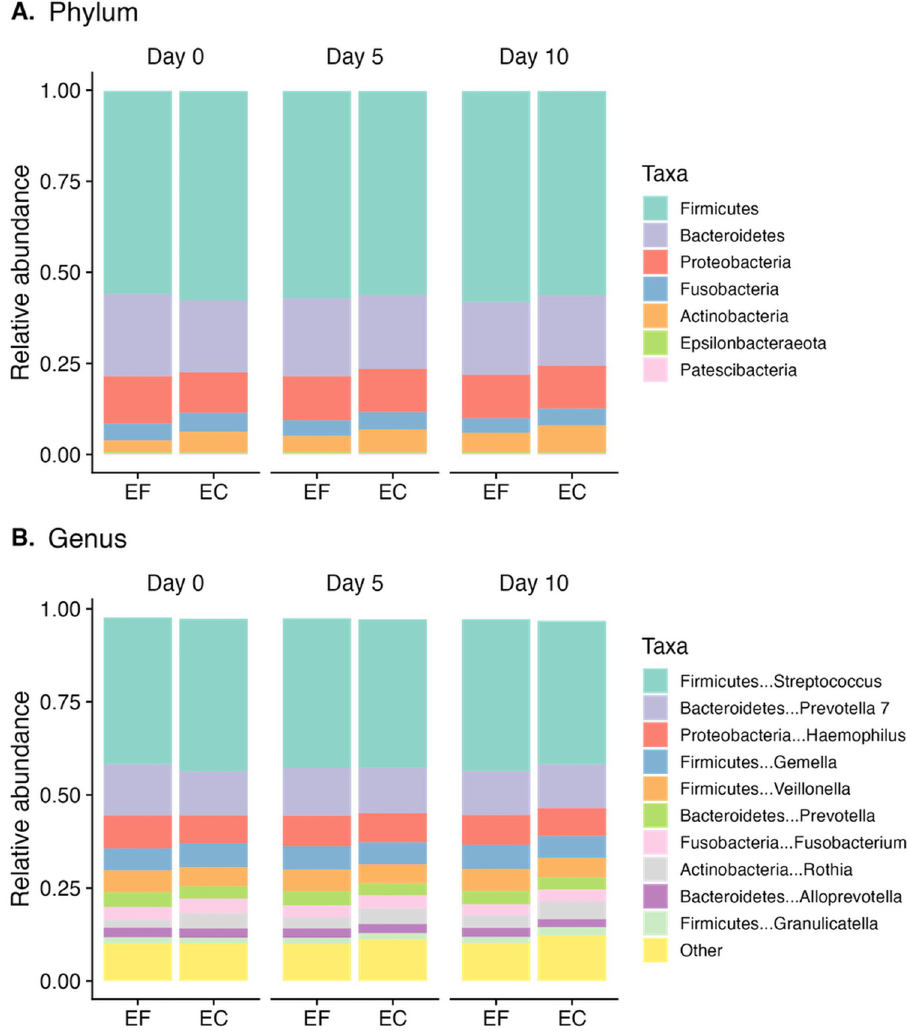
Fig 2. Taxonomic profiles at the phylum (A) and genus (B) levels comparing ethanol-free (EF) and ethanol- containing (EC) mouthwashes at each processing time point.